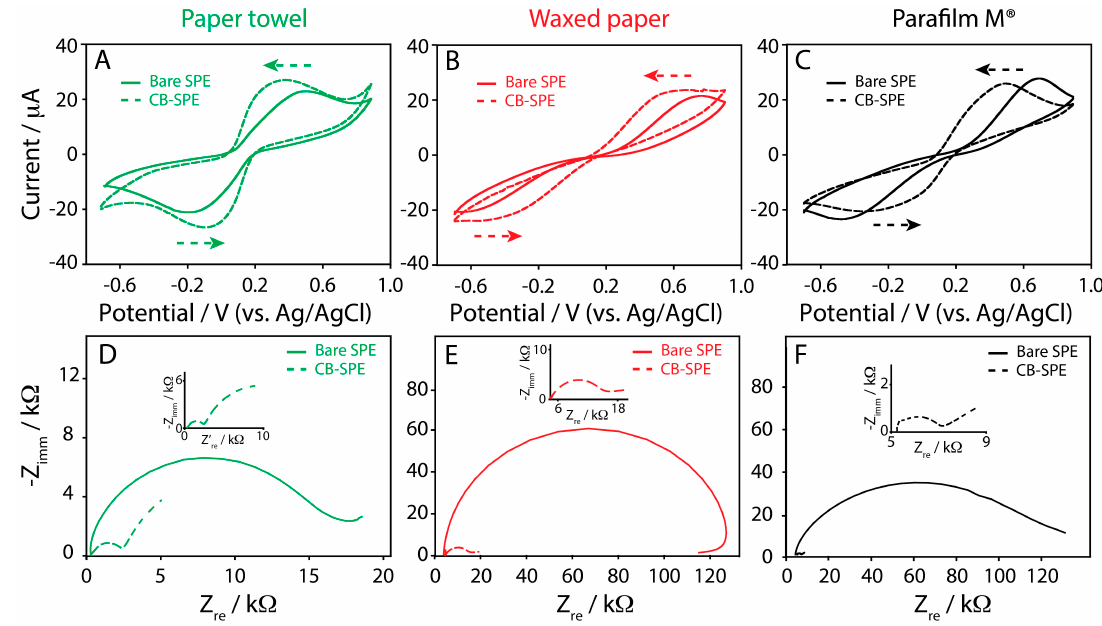
Figure 5. Cyclic voltammograms performed in 2 mM ferricyanide/ferrocyanide (Fe(CN) 63 − /Fe(CN) 64 − ), prepared in 100 mM potassium chloride, at a scan rate of 0.05 V/s, using: ( A ) bare (green solid line) and CB-modified (green dashed line) SPE onto paper towel; ( B ) bare (red solid line) and CB-modified (red dashed line) SPE onto waxed paper; ( C ) bare (black solid line) and CB-modified (black dashed line) SPE onto Parafilm M ® . Complex plane impedance plots at open circuit potential using a 2 mM ferricyanide/ferrocyanide in 100 mM potassium chloride for: ( D ) bare (green solid line) and CB- modified (green dashed line) SPE onto paper towel; ( E ) bare (red solid line) and CB-modified (red dashed line) SPE onto waxed paper; ( F ) bare (black solid line) and CB-modified (black dashed line) SPE onto Parafilm M ® . Insets of Figure 5D–F highlight the complex plane impedance plot for CB-SPE.